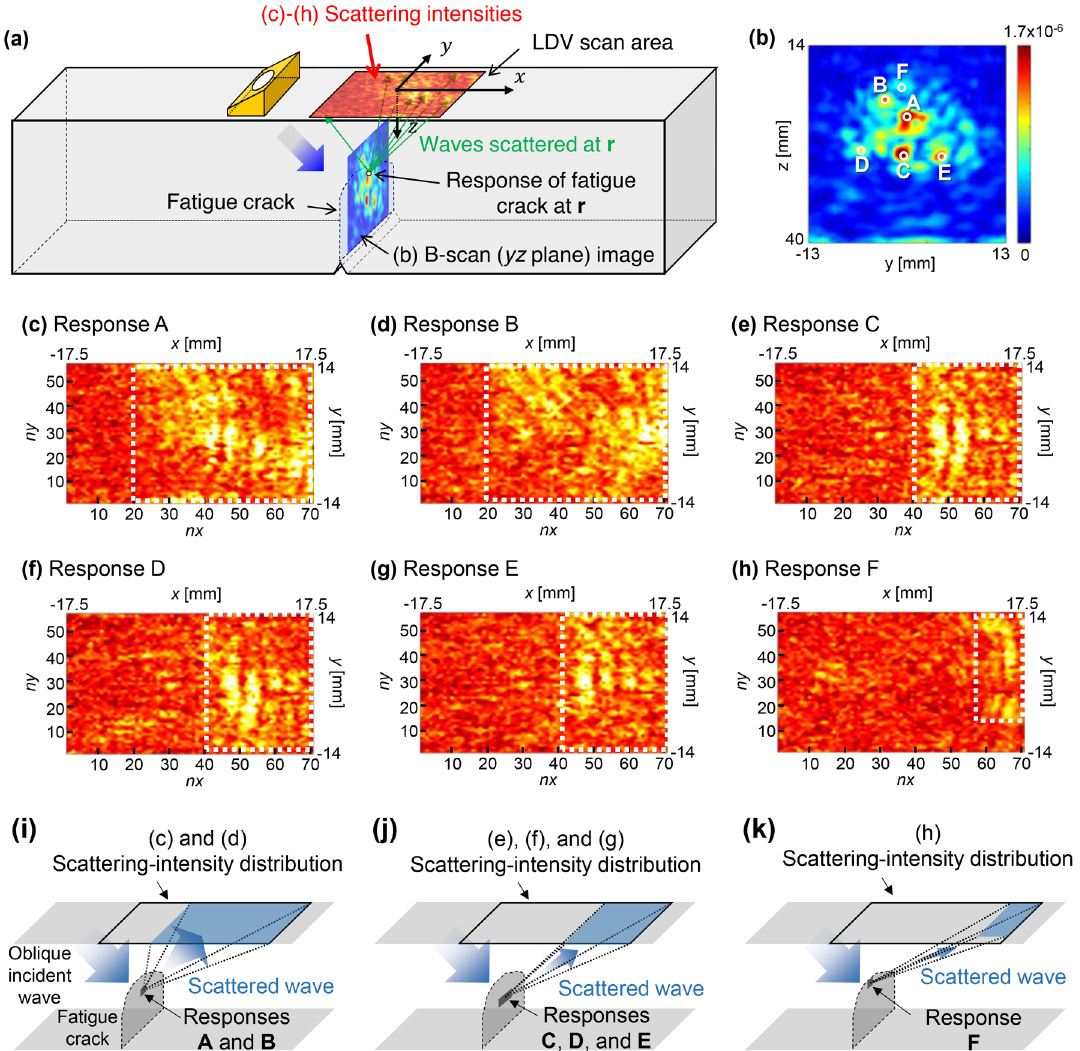
r , nx , ny for various responses within the fatigue (cid:31) (cid:30) r , nx , ny (cid:31) (cid:30)